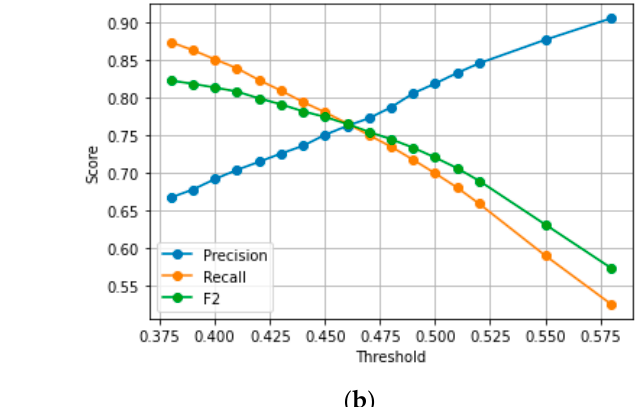
Figure 10. Accuracy measures as a function of the coefficient of Manning for operating point = 0.41. 4. Application to Real Case 4.1. Generation of Input Data The application of the simplified model to a real case requires computing the input data for the ML model from the actual geometry of the reservoir (W c , W r , L r , H r , vol, H c ), the surrounding area (B l , S lb , S t , S lc , L B , Manning) and the location of vulnerable points (D resx , D resy and D channely ), hereinafter the areas of interest (AoI). The geometrical parameters